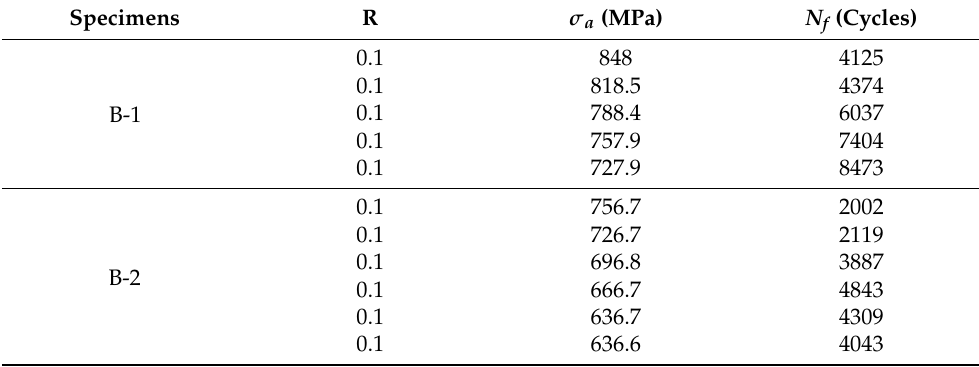
Table 4. Fatigue test data of GH4169 alloy under loadings, data from [29].